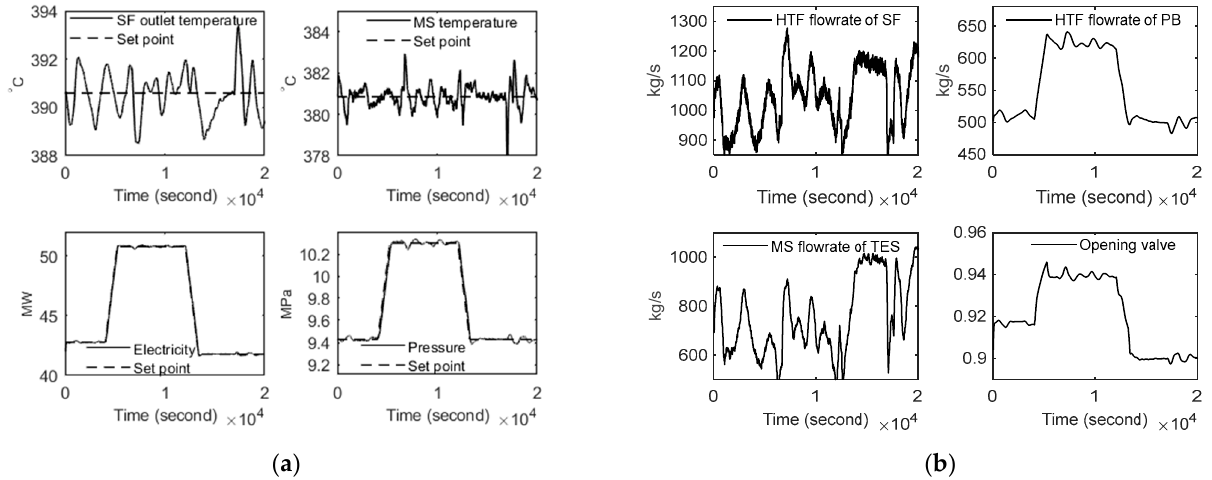
Figure 15. Simulation of wide-range load variation tracking subject to disturbance: ( a ) the controlled variables; ( b ) the manipulated variables.